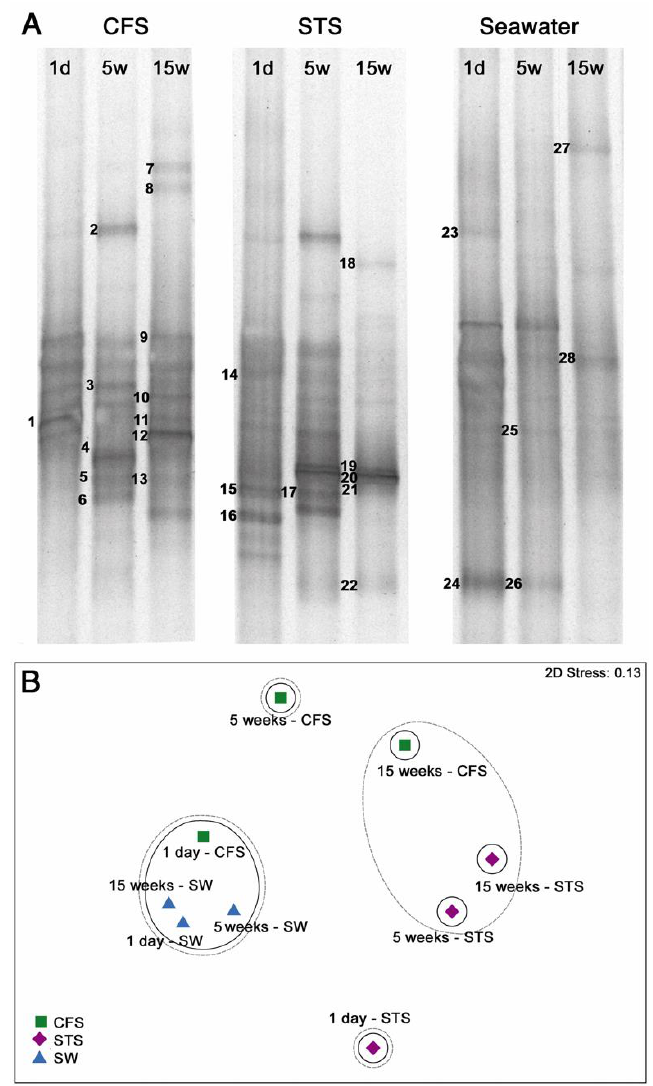
Figure 2. Analysis of the bacterial communities in the biofilms. ( A ) Denaturing gradient gel electrophoresis (DGGE) profiles of 16S rRNA gene sequences from biofilms formed during CFS and STS exposure, compared with the bacterial communities present in bulk seawater at the same time. The numbers indicate the sequenced bands (Table S1, Supplementary information); ( B ) Non-metric Multidimensional Scaling (NMDS) plot representing the analysis of the similarity of S17 Bray–Curtis resemblances between samples from the CFS biofilm, STS biofilm, and seawater (SW). Similarities based on the cluster analysis and SIMPROF test are encircled by a continuous line (60%) and dashed line (40%),